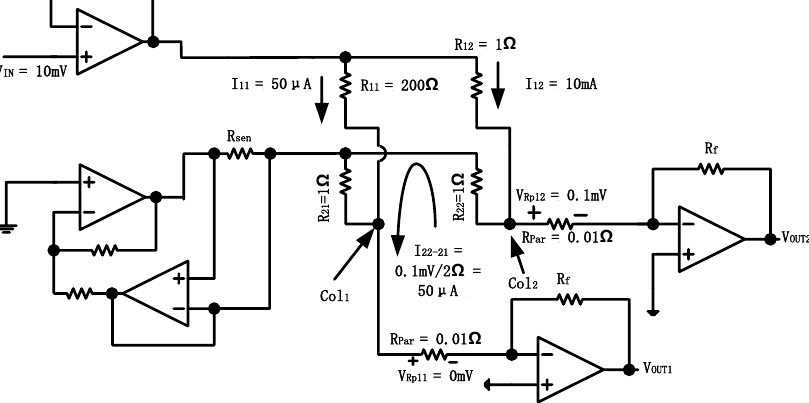
Figure 8. Simplified 2 × 2 array circuit example to demonstrate singular values effect in DZCM.